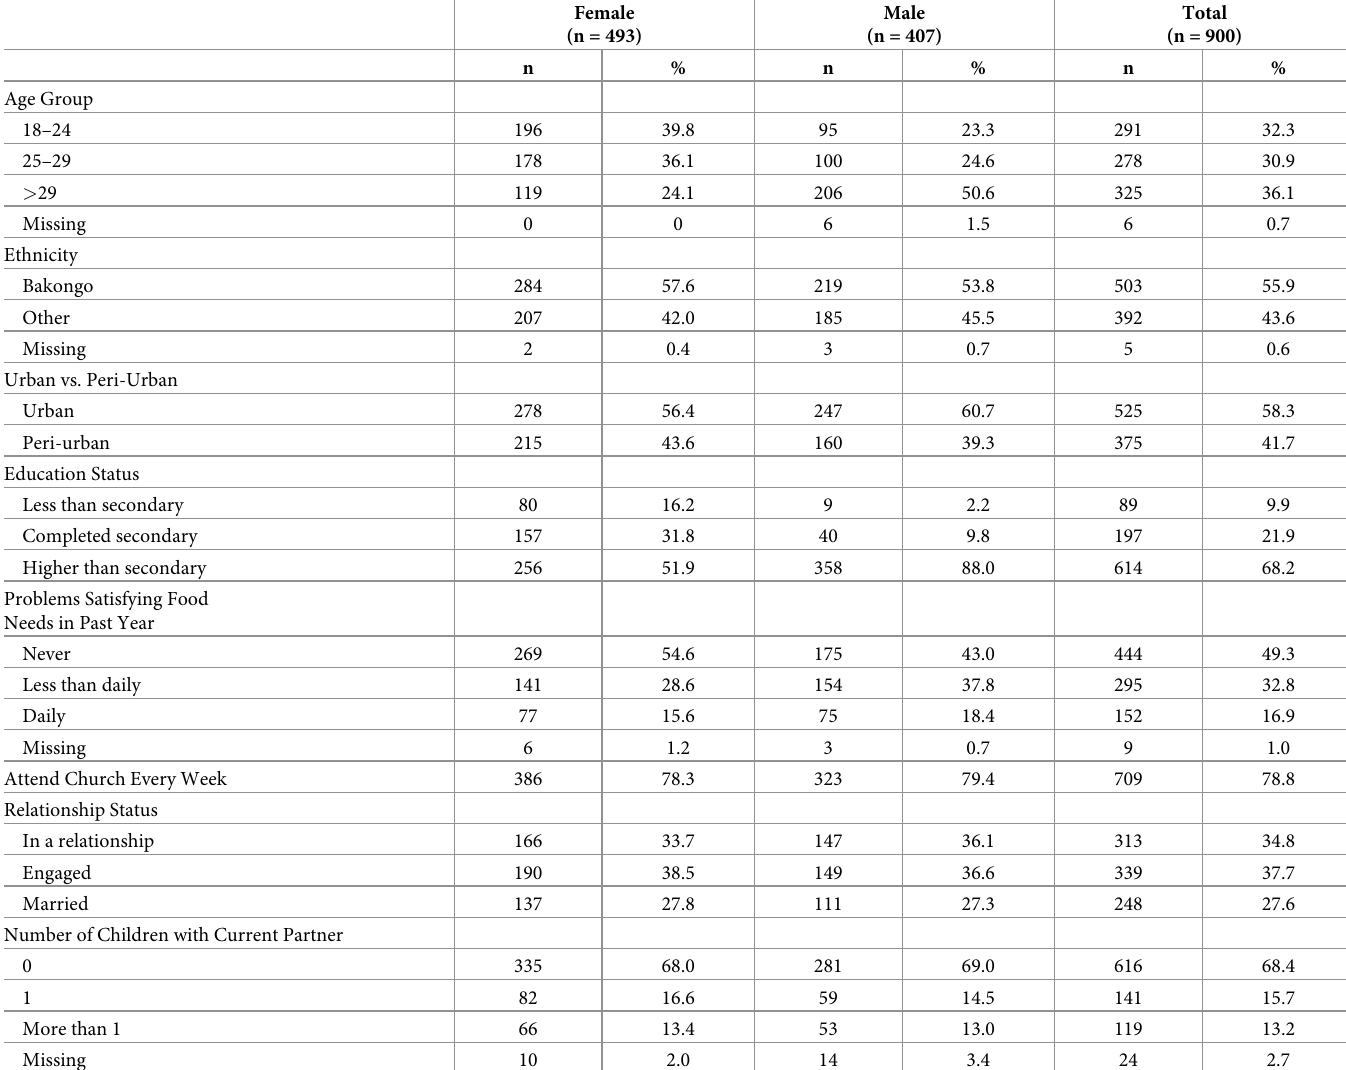
Table 1. Demographic characteristics of male and female survey